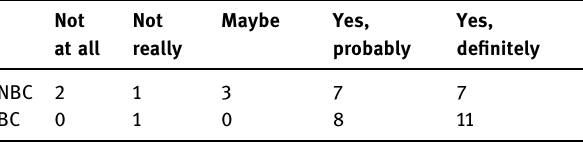
Table 11: Outcome di ff erences between the two repeated measures conditions according to gender